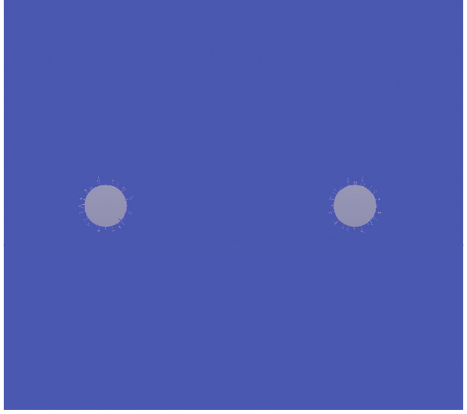
Figure 7: Crack development at 30 μ s of ordinary blasting.